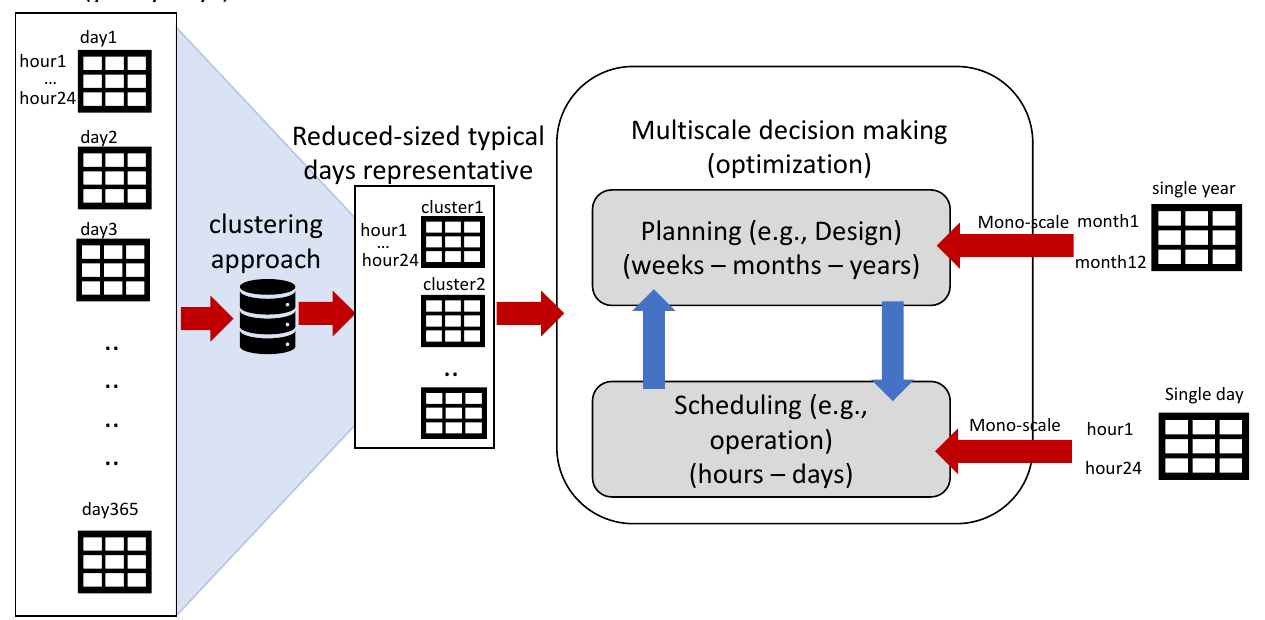
Figure 1. Clustering approach application to the multiscale decision-making problem.